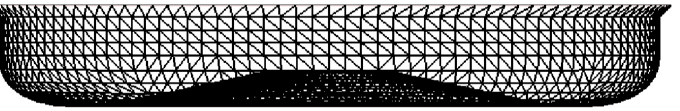
Figure 5. Mesh preview of the combustion chamber.